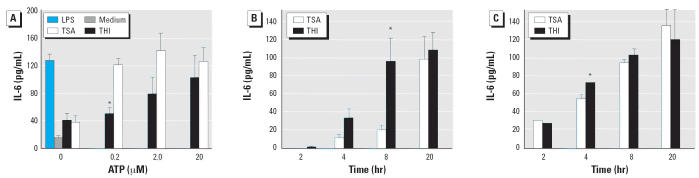
THI suppression or exacerbation of ATP-mediated IL-6 secretion from IDCs
is dependent on the ATP dose. (A) IL-6 accumulation induced by 0.2 μM ATP is suppressed by 100 nM
THI. Kinetics of IL-6 secretion induced by 2 μM ATP (B) or 20 μM ATP (C) is enhanced by 100 nM THI. DCs were pretreated with THI or TSA as in (A). Data are means of quadruplicates ± SE. An independent cell culture
was used for each graph.*p > 0.05.